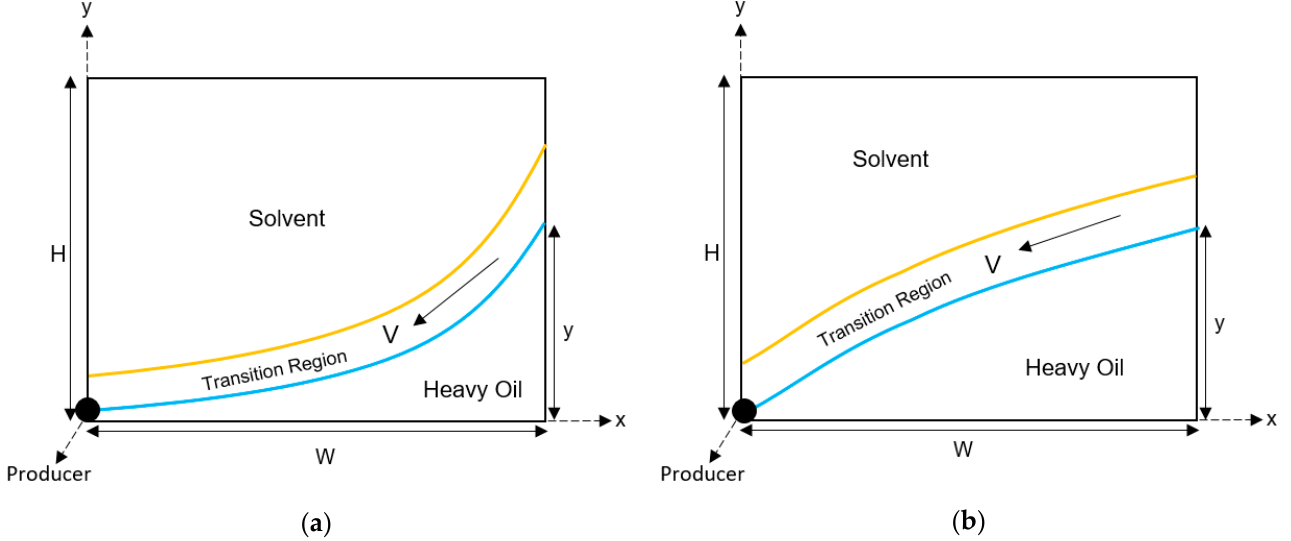
Figure 6. Falling stage of one side of the physical model in the ( a ) concave case and ( b ) convex case.